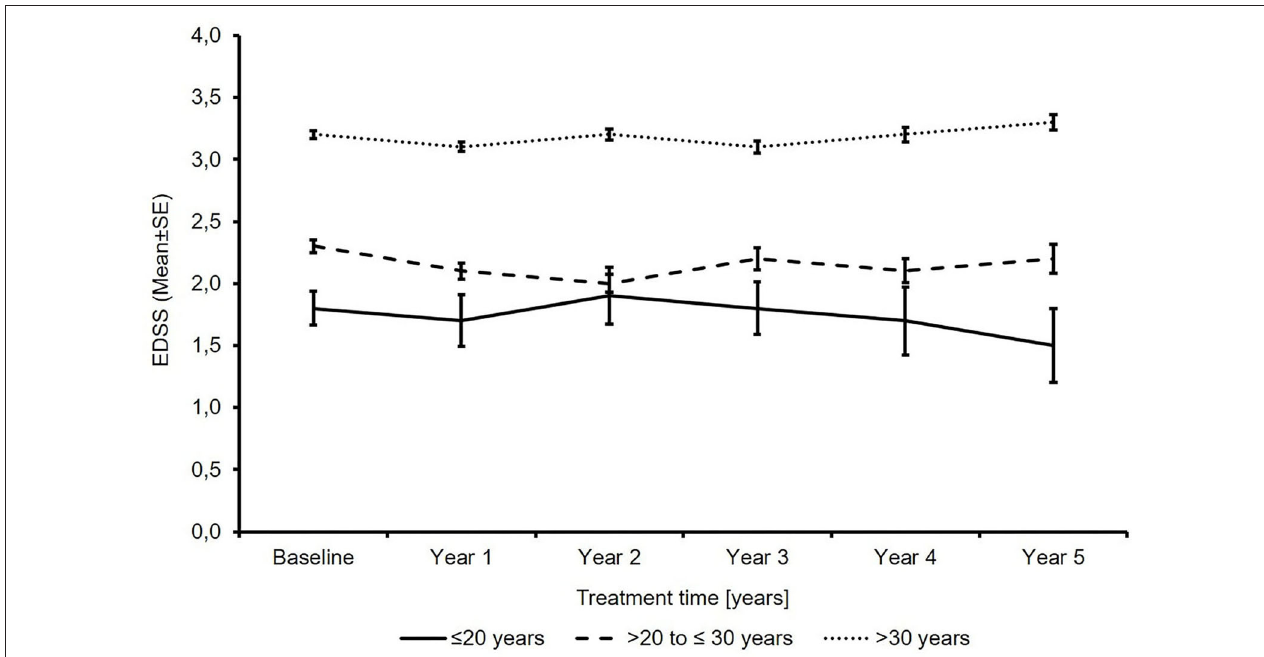
FIGURE 1 | Total expanded disability status scale score ( N ′ ≤ 20 years: 74/53/37/27/18/13; N ′ > 20 to ≤ 30 years: 762/538/409/297/243/184; N ′ > 30 years: 2875/2076/1655/1295/1082/834; baseline/year 1/year 2/year 3/year 4/year 5).